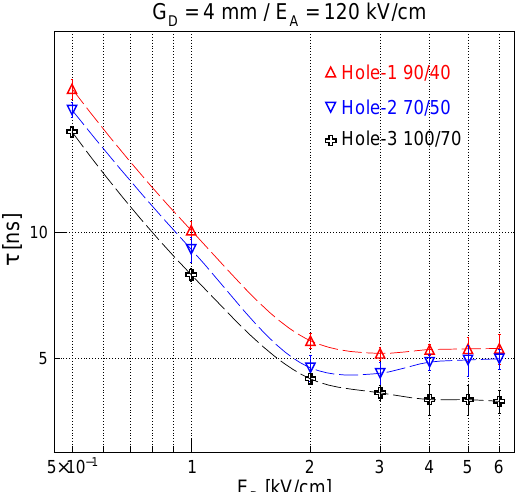
Figure 3. Time resolution vs. E D in a single FTM in Ar/CO 2 (70/30). Hole-3 shows the best resolution. Lines are only to guide the eye.